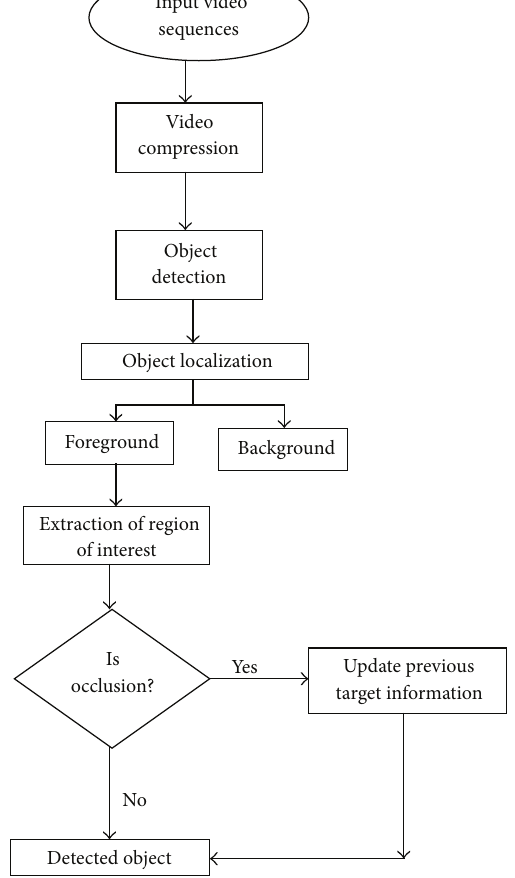
Figure 1: The flow diagram of proposed